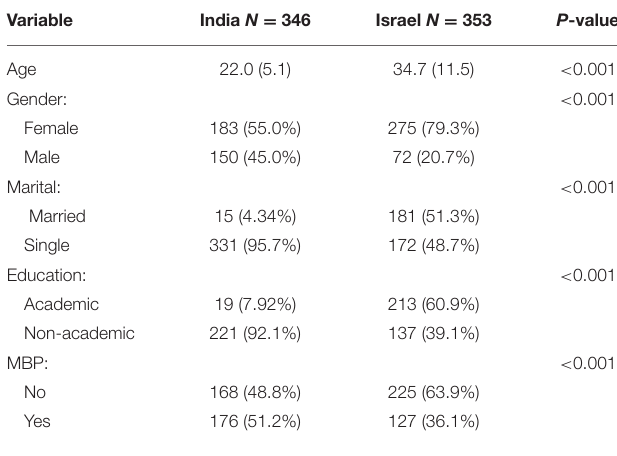
TABLE 1 | Demographic descriptive statistics by